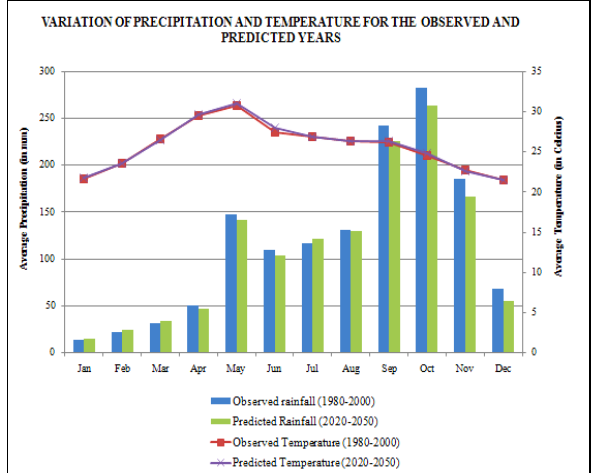
Figure 8. precipitation and temperature for observed (1980- 2000) and predicted years (2020-2050).